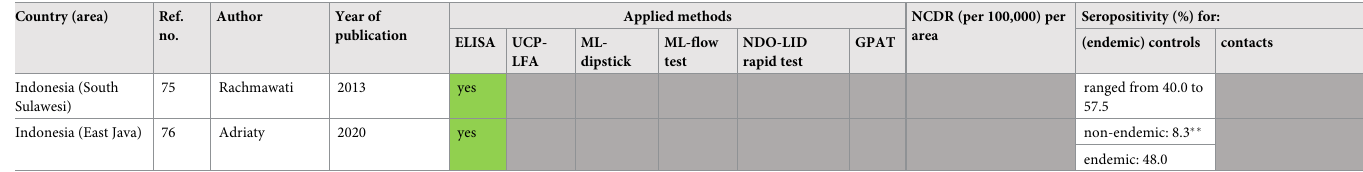
Overview of the prevalence of seropositivity for anti- M . leprae antibodies in children without leprosy sorted per country and test group (endemic controls or contacts of leprosy patients). For each study, the country, reference number, author, year of publication, laboratory assay and seroprevalence (%) for M . leprae antibodies are reported for either (endemic) controls or (household) contacts of leprosy patients. For the numbers of children included and the method used per study, we refer to the Supplementary. The boxes in grey indicate that this data was not available. The antibody subtypes measured are indicated by the colors in the applied methods column; green: immunoglobulin M (IgM), blue: immunoglobulin A (IgA), yellow: immunoglobulin G (IgG), orange: both IgM and IgG and purple: not reported. � Estimated from graph/figure. �� Reportedly leprosy non-endemic